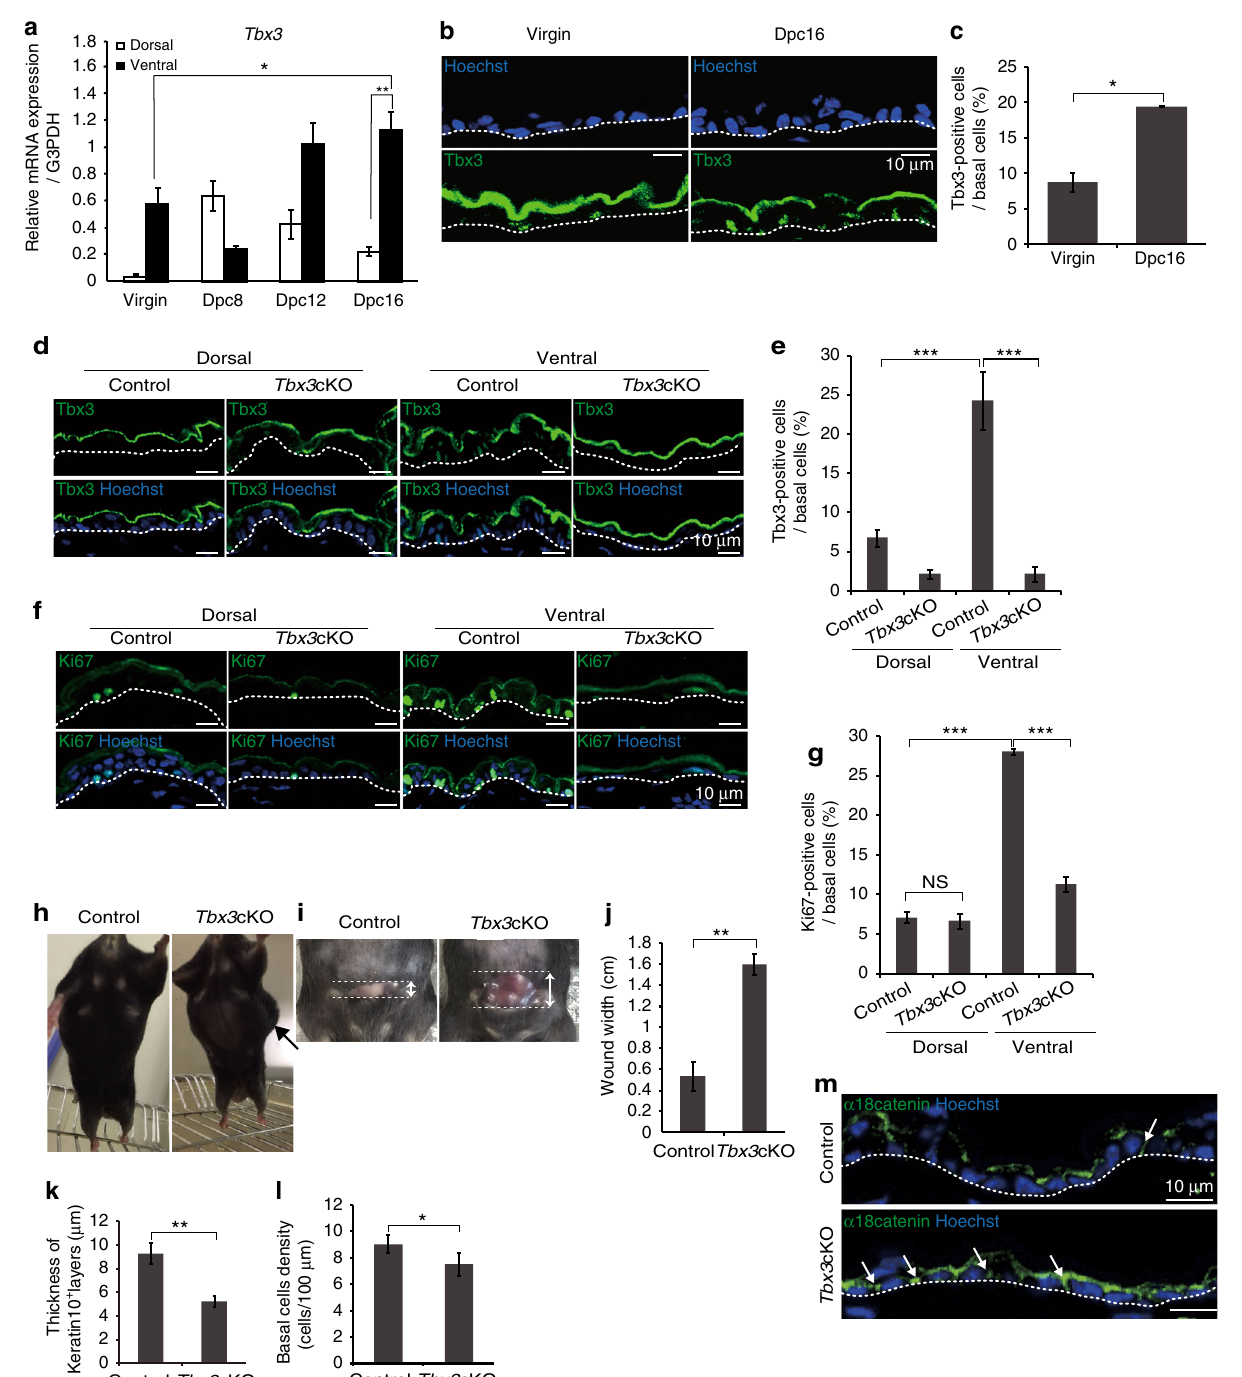
of geminin + cells ( n = 57 from three mice) expressed Tbx3. In addition, Tbx3 protein was detected in the geminin − cell popu- lation (20%, n = 330 from three mice), indicating cell cycle- independent expression of Tbx3. Nonetheless, the Tbx3 + IFE basal cells incorporated EdU at a signi fi cantly higher rate than Tbx3 − IFE basal cells in the abdominal skin at 16 dpc (Fig. 3a, b). These results suggest expression of Tbx3 in a highly proliferative basal cell population that emerges in the abdominal skin during pregnancy. As a second experiment to characterise the Tbx3 + IFE basal cells, we used Axin2 reporter mice. A recent study